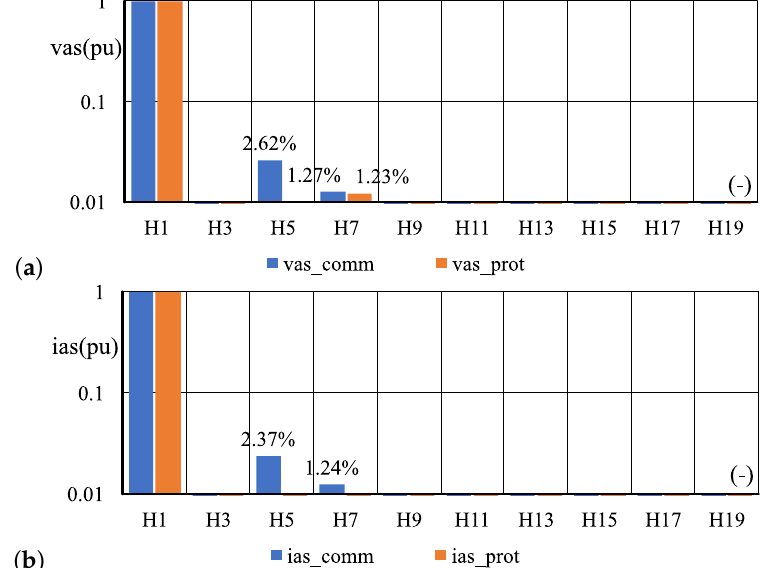
Figure 12. Measurement of armature voltage and current of the salient and non-salient BSG in load conditions (balanced star connected load R = 0.8 Ω , X = 0.15 Ω (@400 Hz), p . f . = 0.98), ( a ) harmonic content of voltage waveforms, ( b ) harmonic content of current waveforms (vas_comm, ias_comm—results for salient pole generator, vas_prot, ias_prot—results for non-salient pole